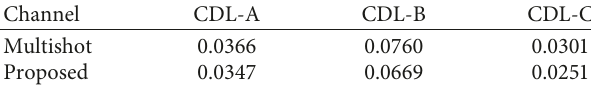
Table 4: RMSD results under multicluster cases.